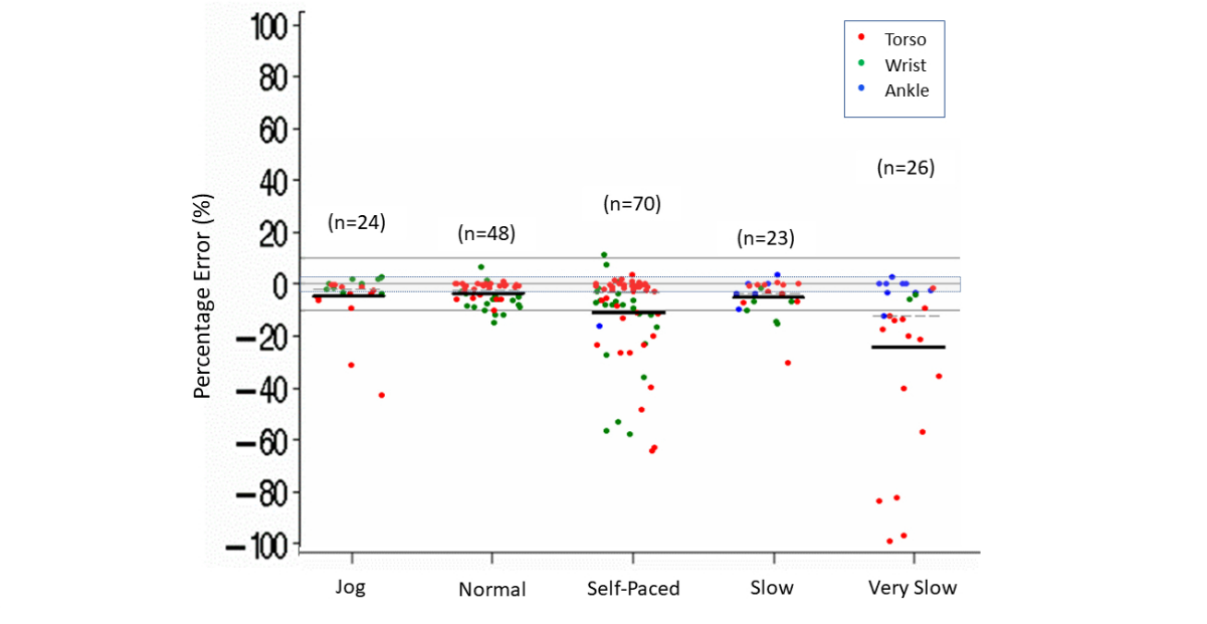
Figure 3. Step count percentage error in controlled settings. Speed (jog, normal, self-paced, slow, very slow) by body placement (torso, wrist, ankle) of the Fitbit device. Dark lines indicate mean (horizontal). Dashed lines indicate median (horizontal). Gray shading indicates ±3% measurement